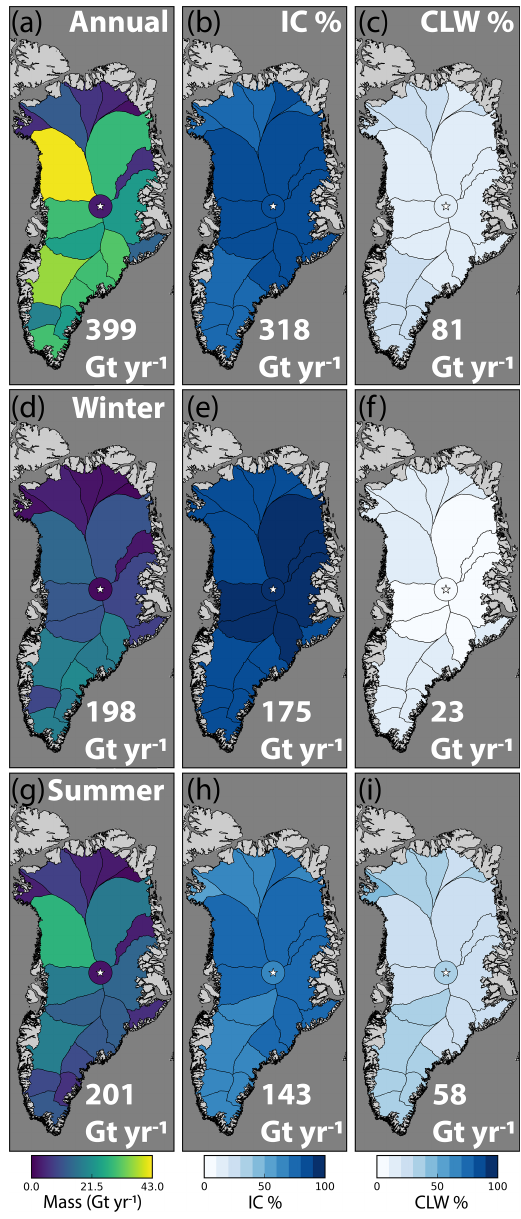
Figure 5. Snowfall mass contribution to the GrIS. Panel (a) is the annual average mass contribution broken down by basin, with the color scale representing Gtyr − 1 for each basin and the total mass listed in the bottom right corner. Panel (b) is the percentage of the snowfall mass produced by ice clouds, and panel (c) is the percent- age of the mass produced by liquid-containing clouds. The center (d, e, f) and bottom (g, h, i) rows are as the top row but for win- ter (October–April) and summer (May–September) months, respec- tively. The location of Summit Station is marked in each panel by a white star, and the color of the circle surrounding it indicates the mass/percentage value for the area within 100km radius of the sta-